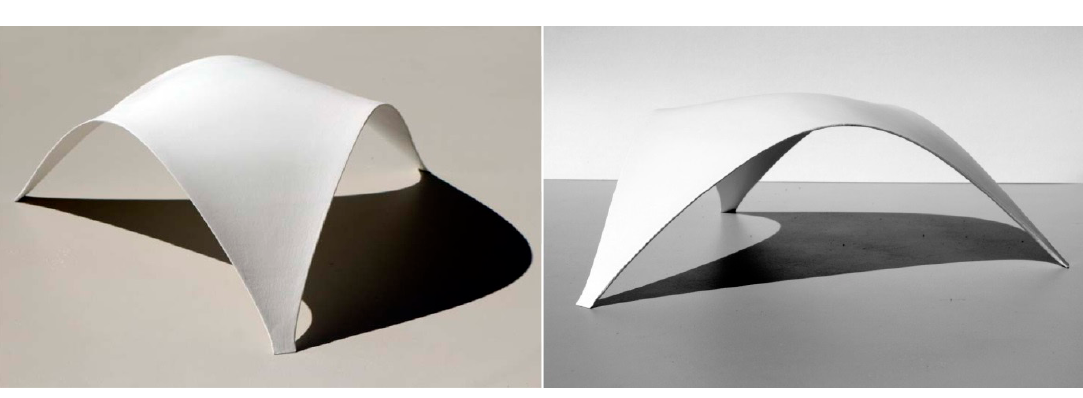
Figure 12. Final scale model: ( 1 – 3 ) different views of the final scale model; ( 4 ) preliminary tests at the closed circuit aerodynamic tunnel at LNEC.